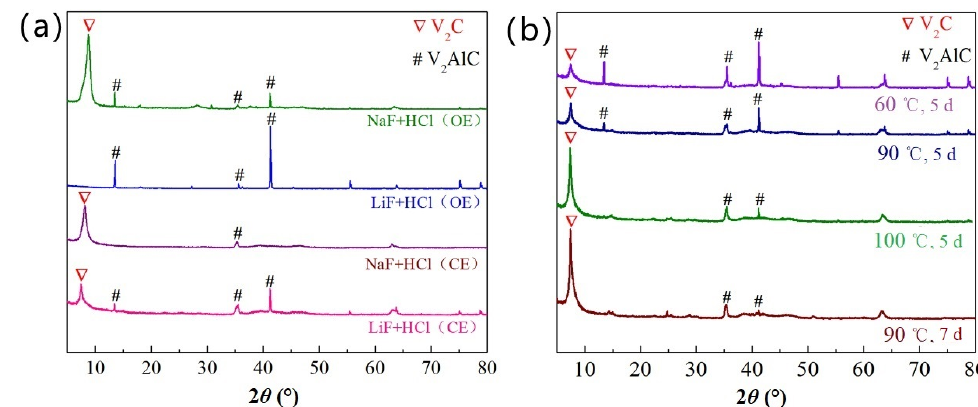
Fig. 14 XRD patterns of V 2 C MXene prepared under different process conditions: (a) etching at 90 for 5 d with NaF+HCl ℃ or LiF+HCL in OE or CE; (b) etching in CE with LiF+HCl for different days (5 and 7 d) at different temperatures (60, 90, and 100 ). Reproduced with permission from Ref. [122], ℃ © The Author(s)